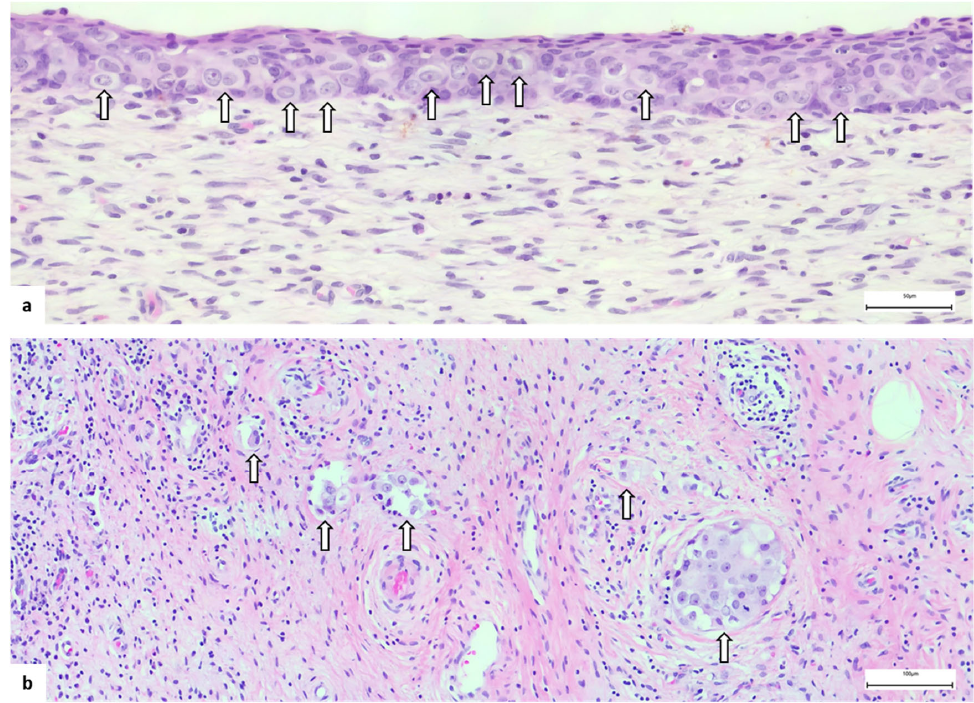
Figure 5. Cervical EMPD: ( a ) intraepithelial and ( b ) invasive. Note the (arrow) Paget cells, with clear cytoplasm and prominent nucleoli, arranged as single cells or little clusters in the ectocervical epithelium ( a ) and as gland ‐ like structures in the cervical stroma ( b ).